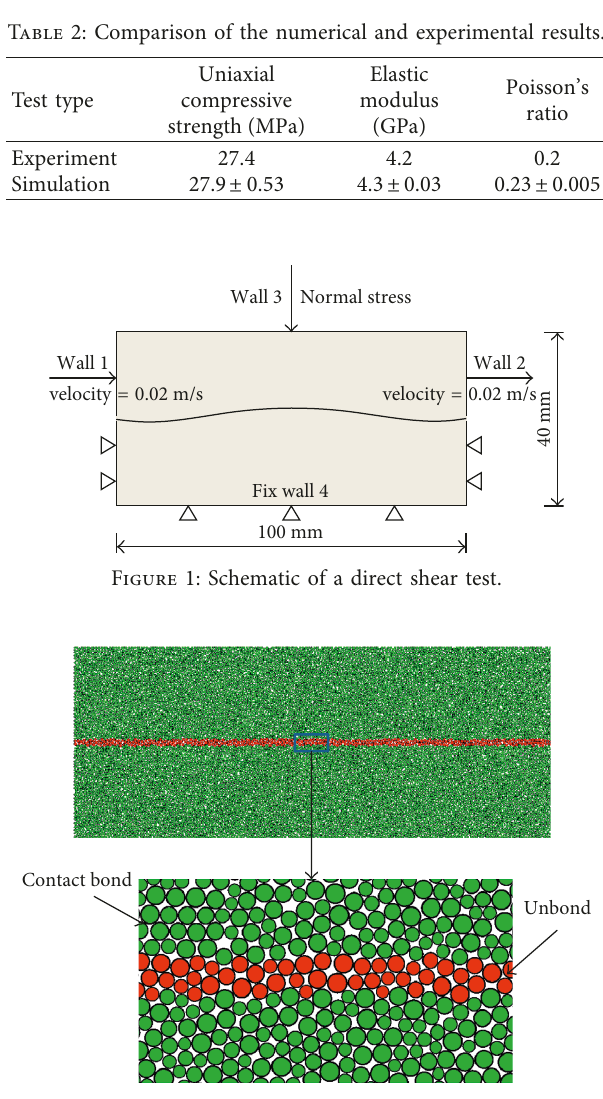
Figure 2: Numerical horizontal persistent jointed specimen gen- erated by the removing bond method.